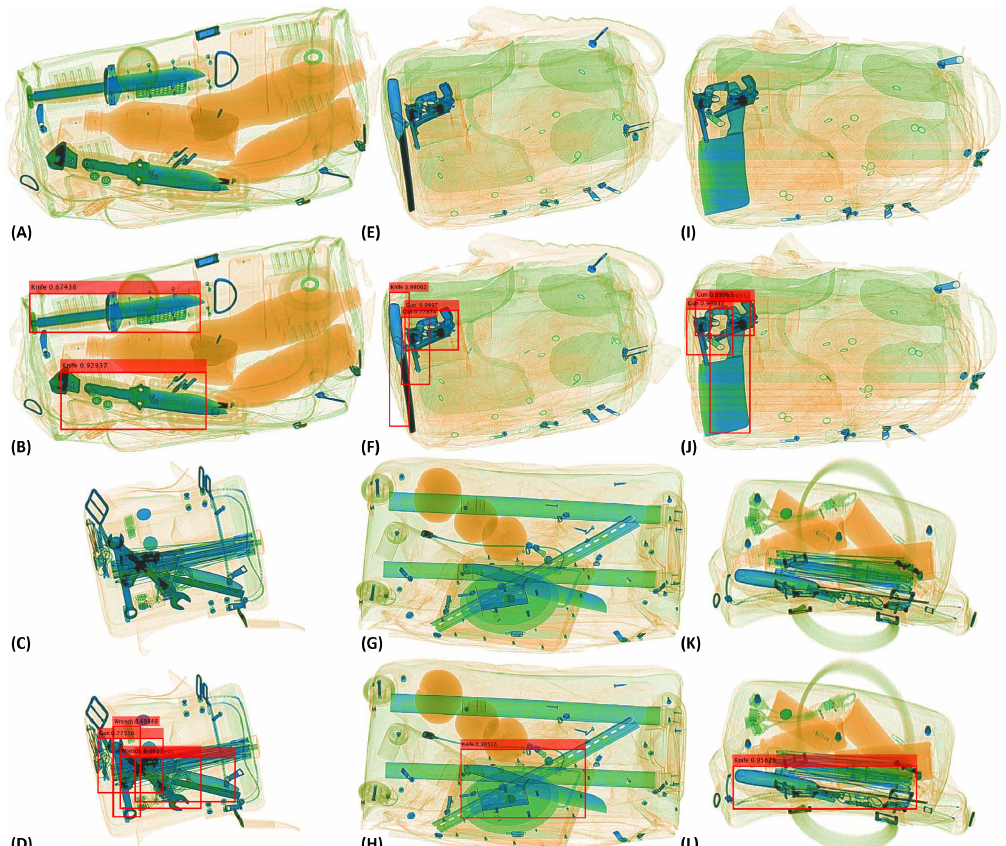
Figure 5. Qualitative performance of the proposed framework on the SIXray [14] dataset for detecting contraband items such as knives , guns , and wrenches as shown in ( A – L ). Moreover, first and third row show the original scans. These samples showcase the effectiveness of the proposed framework in detecting gun , knife , and wrenches in ( D ), a cluttered knife in ( H , L ), and the overlapping guns and a knife in ( J